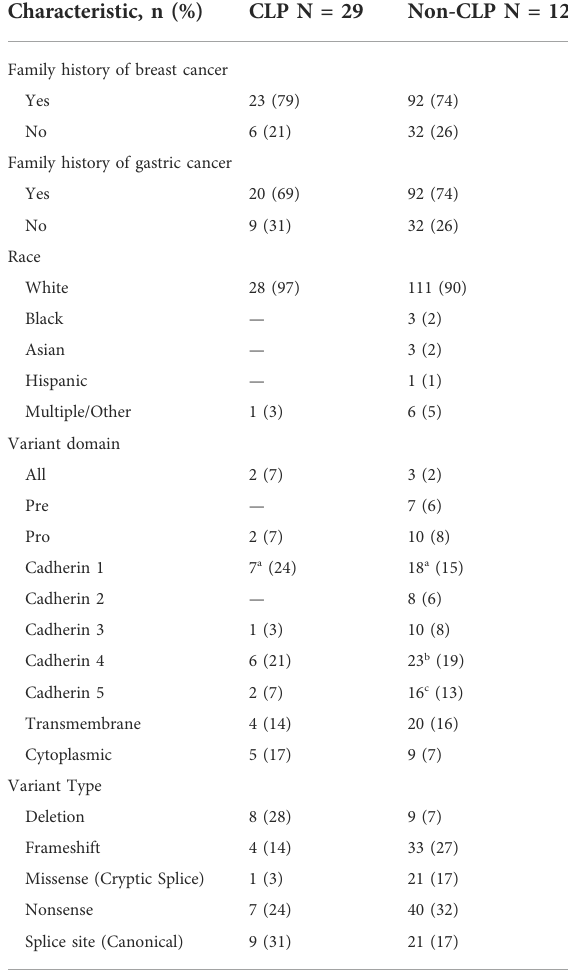
TABLE 1 Family demographic and variant characteristics of CLP and non-CLP